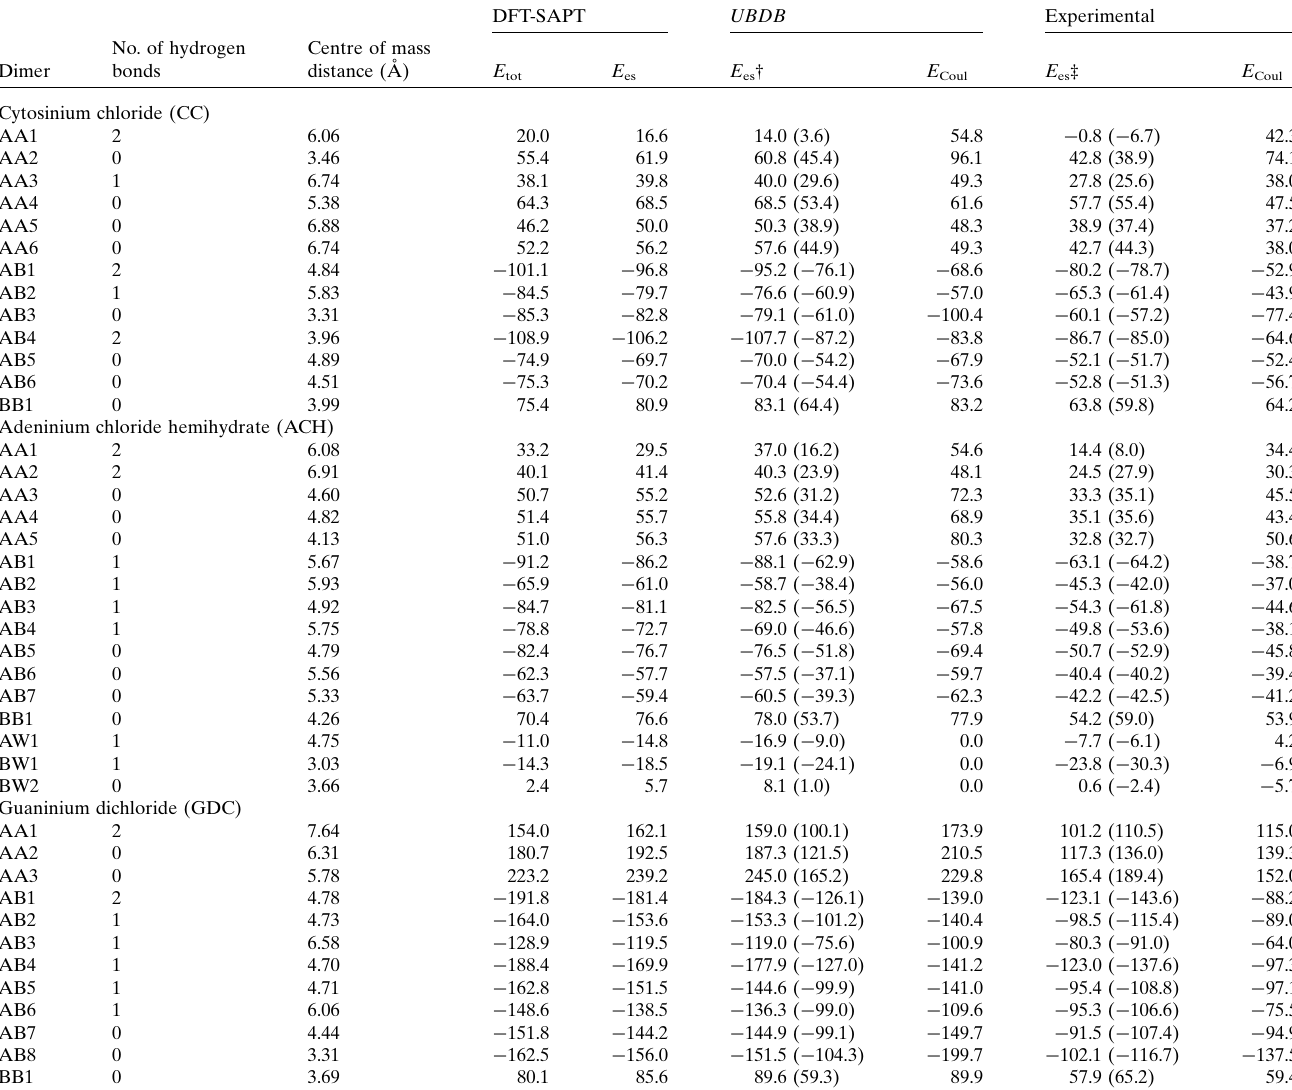
Table 4 Total interaction energies E tot (kcal mol (cid:4) 1 ) according to the SAPT method and electrostatic contributions (kcal mol (cid:4) 1 ) to the total interaction energy for selected dimers extracted from the CC, ACH and GDC crystal structures according to different methods. E es is the electrostatic energy computed from exact integration of charge densities and E Coul is the electrostatic energy computed from the monopole moments of the molecules. For the symmetry operations required to build particular dimers, see Table S2 in the supporting